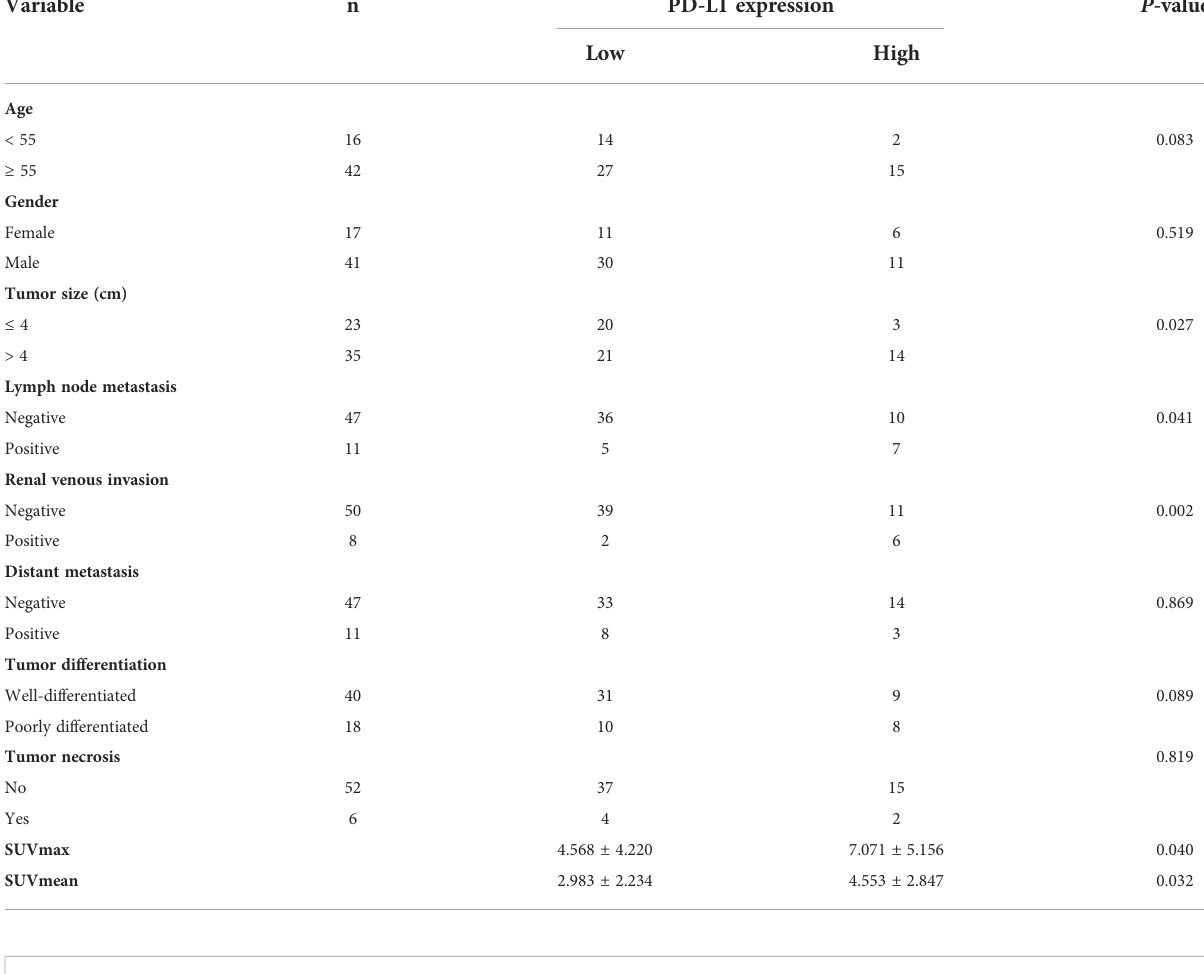
TABLE 1 Relationship between PD-L1 expression and clinical